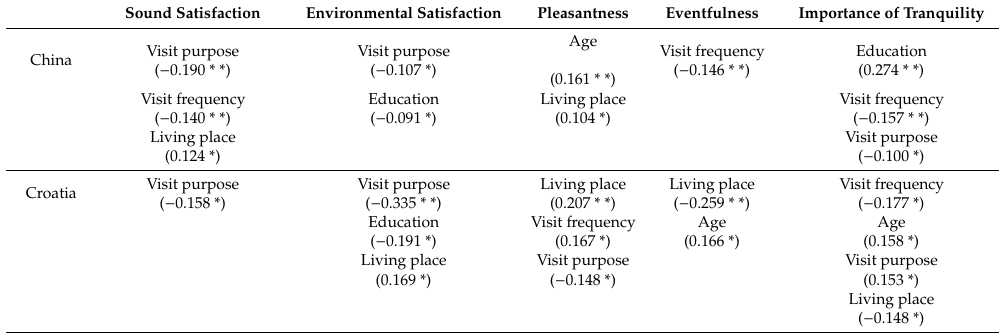
Table 6. Spearman’s rho correlations between subjective satisfaction, tranquility importance as well as soundscape factors, and demographic / social factors of gender, age, education, living place, visit frequency and visit